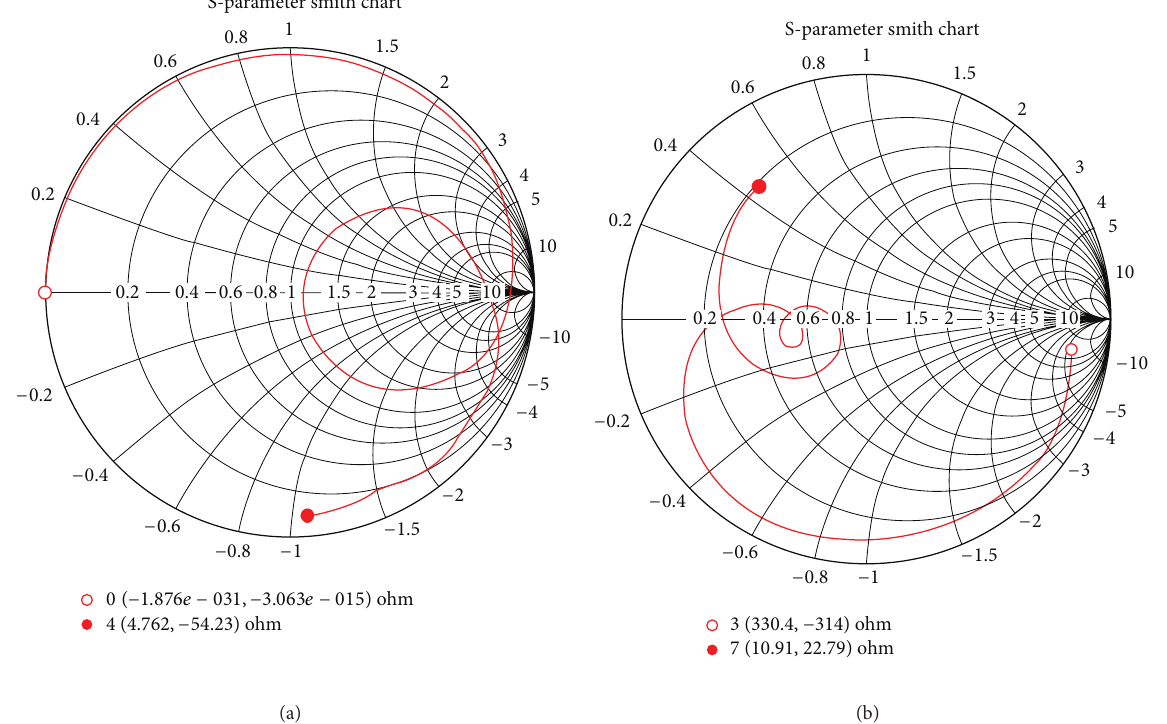
Figure 13: Smith chart of the complex reflection coefficient of the dual-band MK2 PIFA in the overlapping frequency ranges DC-4GHz and 3–7 GHz.